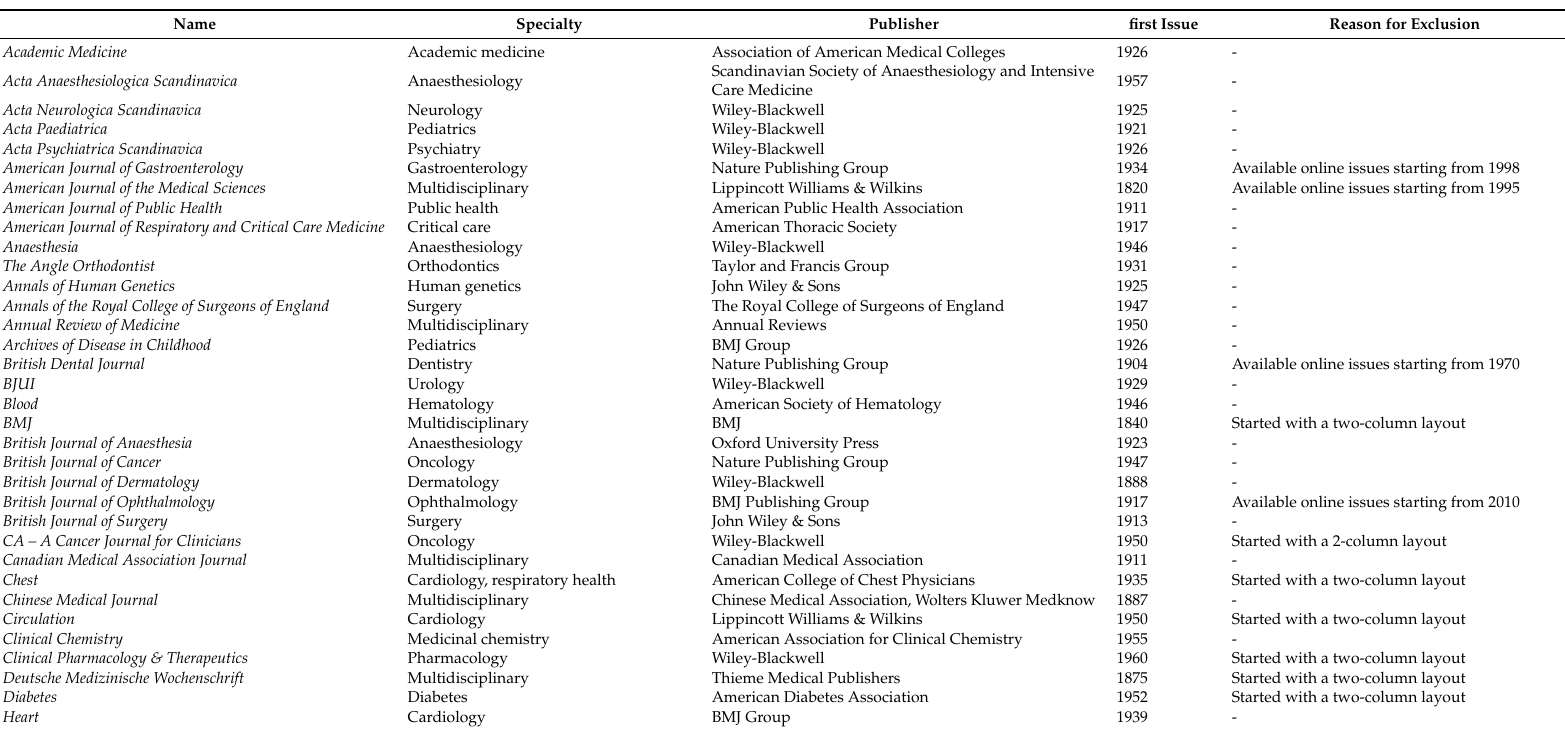
Table A2. Complete list of the screened journals. Reasons for exclusion are provided. If no reason for exclusion is listed, the journal was included in the present